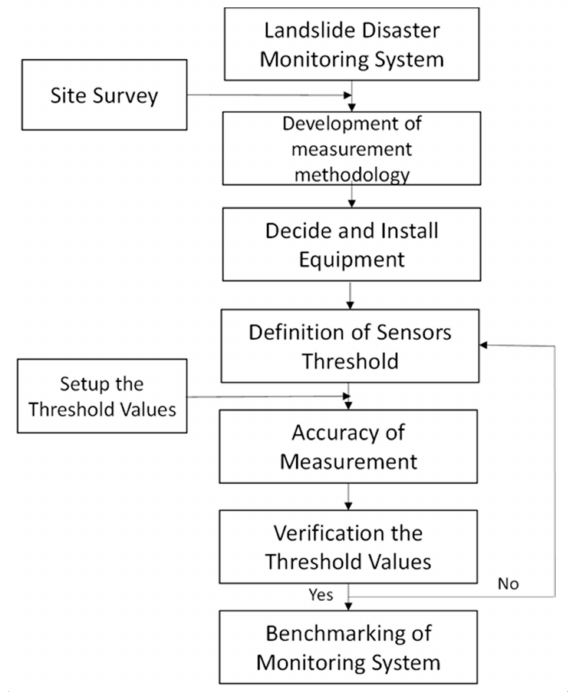
Figure 4. Research methodology